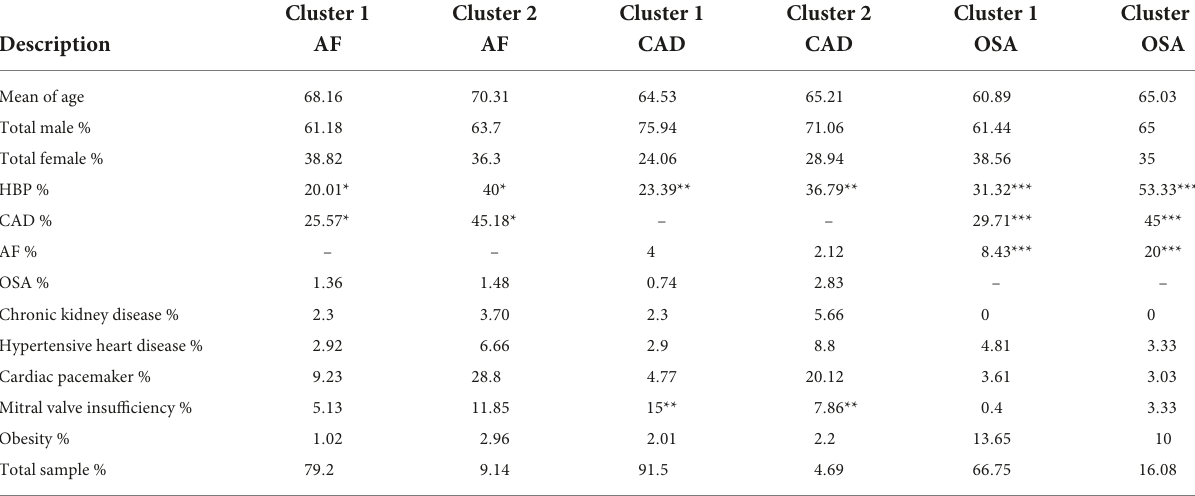
The twoclusters withthe largestnumber of patientsfor AF,CAD, and OSAare includedin the table.The meanof age, thepercentage ofmale andfemale, and thefrequency forthe most prevalent disease for each cluster are reported. Although AF, CAD, and OSA were most prevalent in male, the percentage of female affected in each cluster was high. The most prevalent